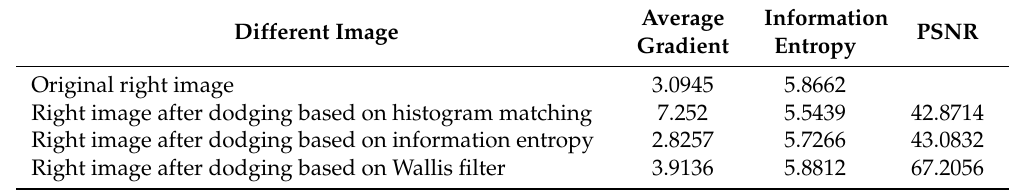
Table 2. The quality evaluation of images processed by different algorithms. Different Image Right image after dodging based on Wallis filter